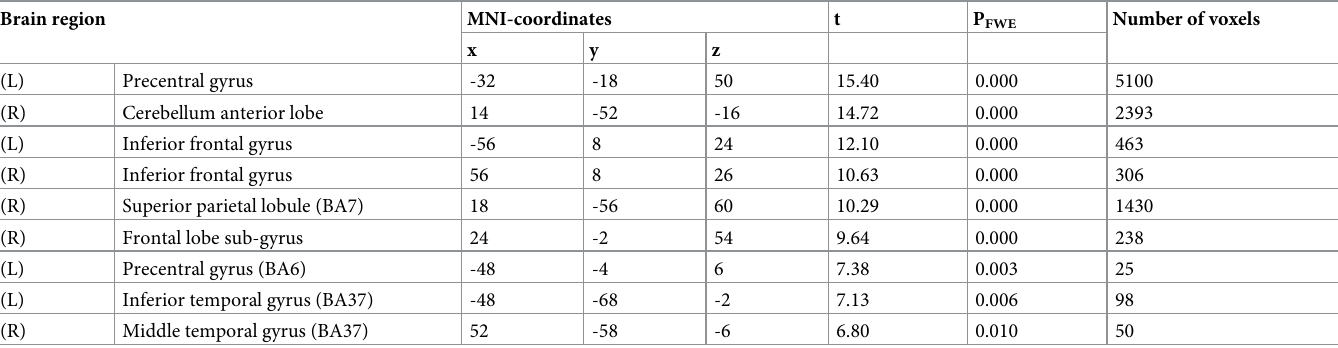
Table 2. Brain activation for copy drawing (A2) versus viewing (A1). Brain region